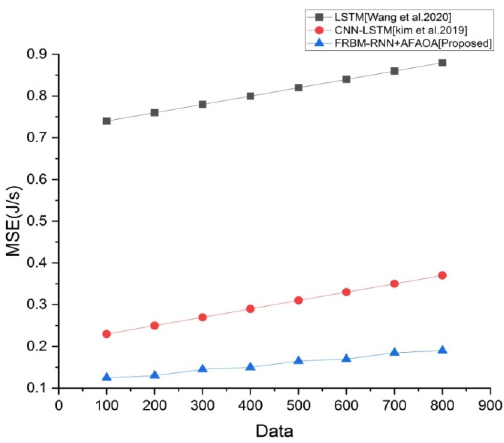
Figure 5. Graphical analysis of different models based on MSE [Source: Author].